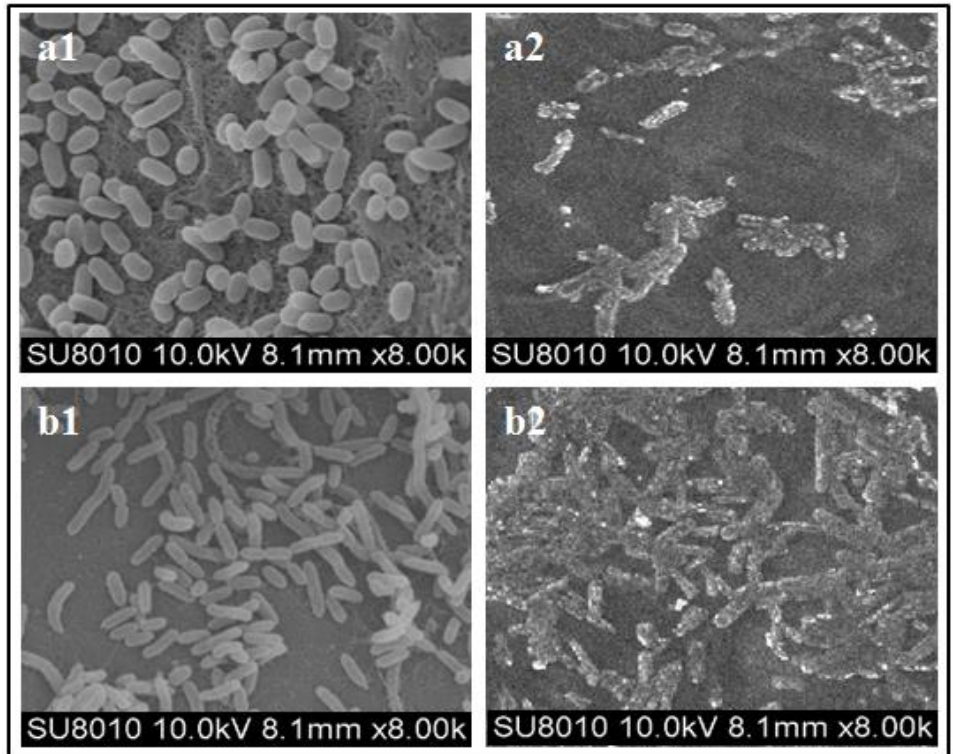
Figure 3. SEM micrograph of ( a1 ) untreated normal R. solanacearum cells; ( a2 ) treated R. solanacearum cells with SMs of T. pseudoharzianum (T113) obtained solid media; ( b1 ) untreated normal X. compestris cells; ( b2 ) treated X. compestris cells with T. pseudoharzianum (T113).